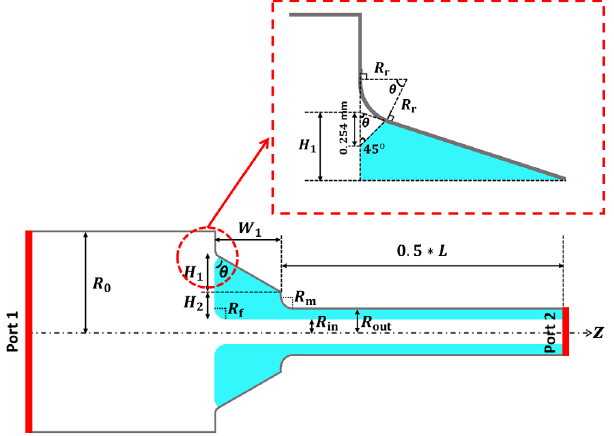
FIG. 6. Simulated S 11 and S 21 as a function of frequency for the compact dielectric matching section.